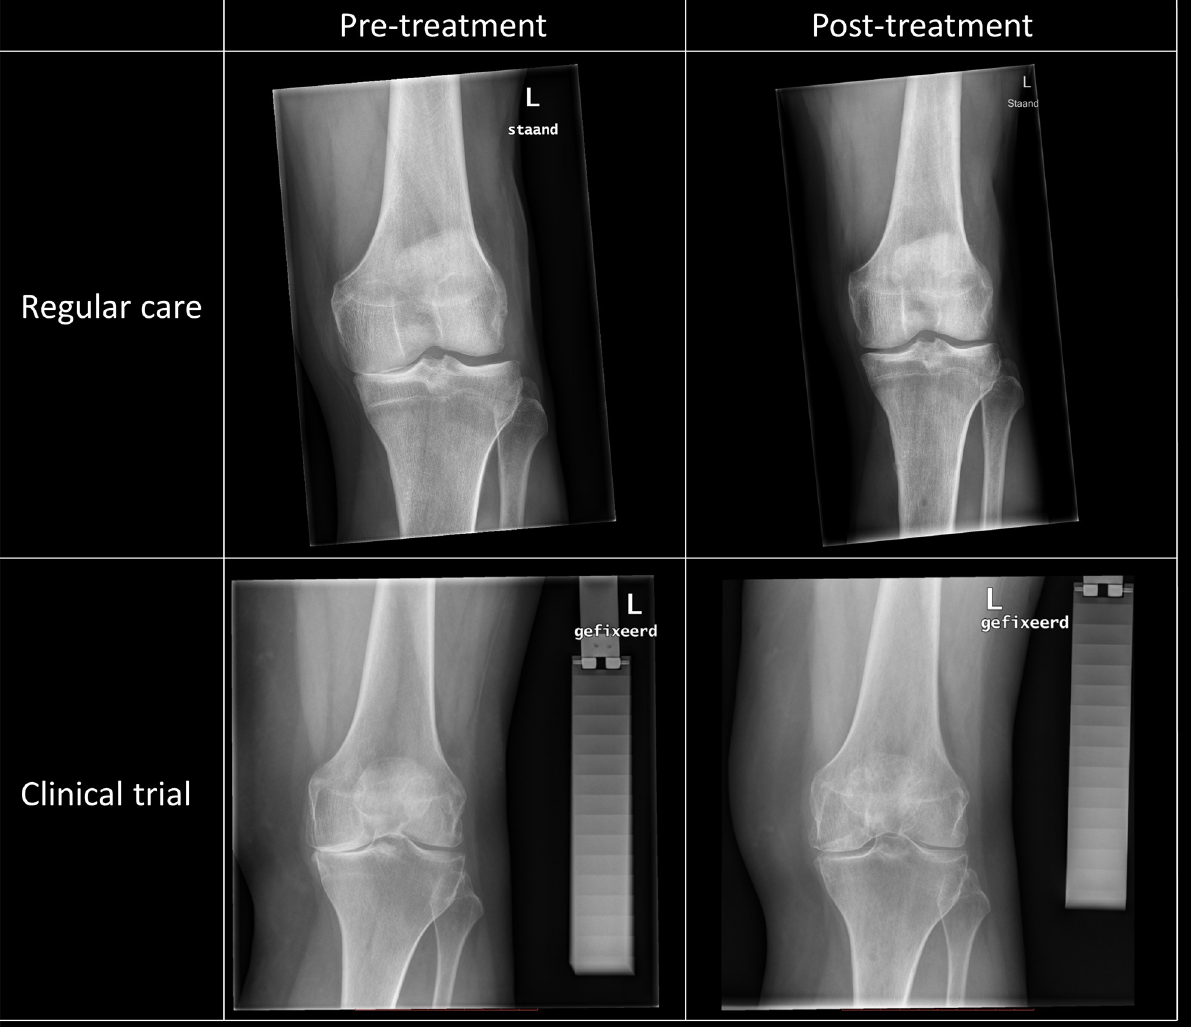
Fig 2. Representative radiographs pre-treatment and one year post-treatment for regular care and clinical trial patient. Note the aluminum step wedge needed for joint space width quantification as used in clinical trials.